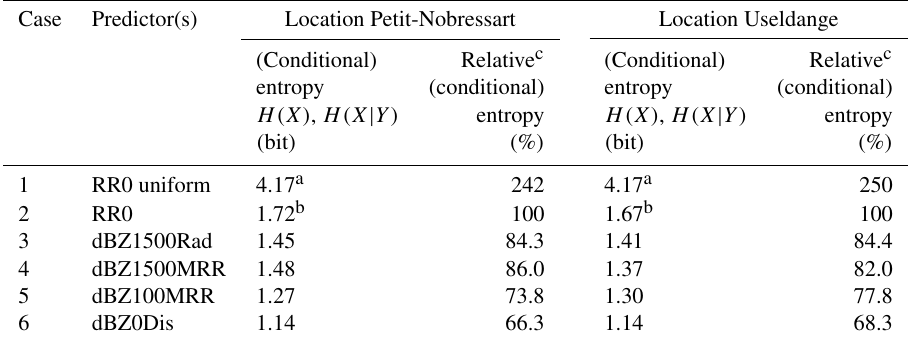
Table 3. Entropy of the target (RR0) and the benchmark distribution (RR0 uniform), conditional entropies of the target given various predictors along the radar path, non-normalized and normalized, for Petit-Nobressart and Useldange, respectively. Underlying data are from the filtered data set. Predictors are ordered by decreasing distance to the